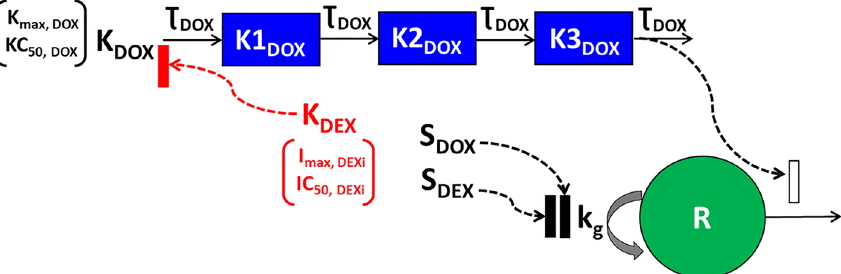
Figure 1. Schematic of the in vitro cellular-level toxicodynamic model (TD) for the single and combinatorial effects of Doxorubicin (DOX) and Dexrazoxane (DEX) on AC16 human cardiomyocytes. Definitions of parameters for the model are listed in Table 1. The solid lines with arrows denote turnover of the indicated response. The green circle represents cell viability while the blue boxes represent transit compartments to describe the delay in the stimulation of death by DOX. Solid black rectangles represent inhibition and open solid rectangles represent stimulation processes induced by DOX and DEX as single agents and as indicated by dashed black arrows. The cardioprotective effect of DEX on DOX-induced cardiotoxicity is indicated by red dashed arrows, with the red solid rectangle representing an inhibition process.